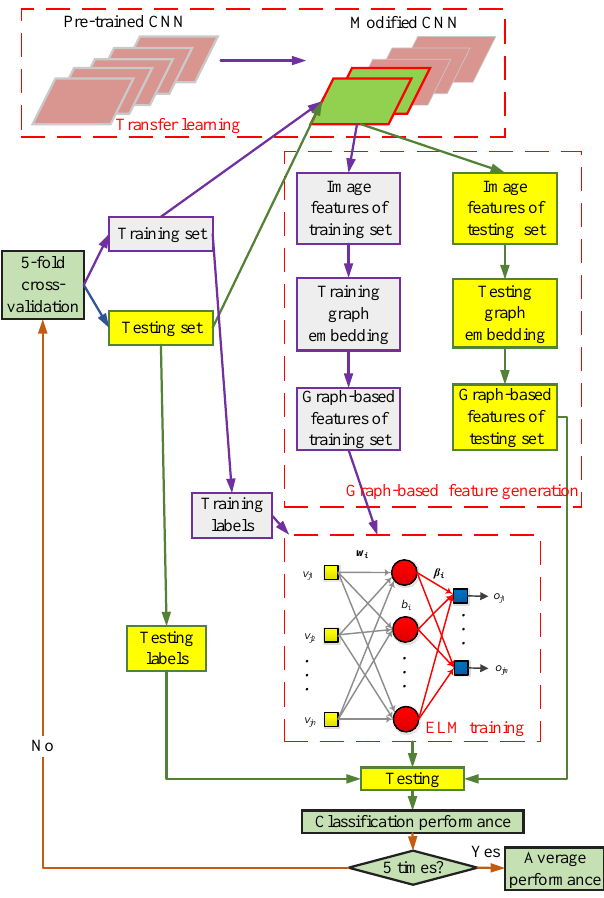
Figure 2. Pipeline of the proposed CGENet.